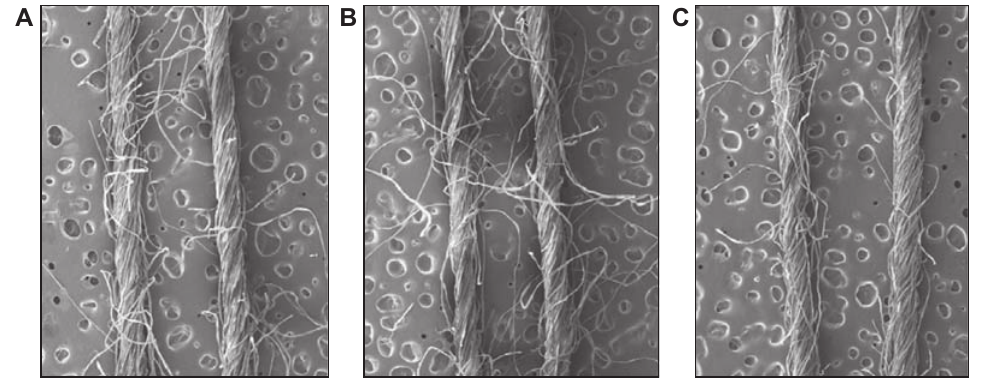
Figure 6 Jetring yarn appearances (56 × ).